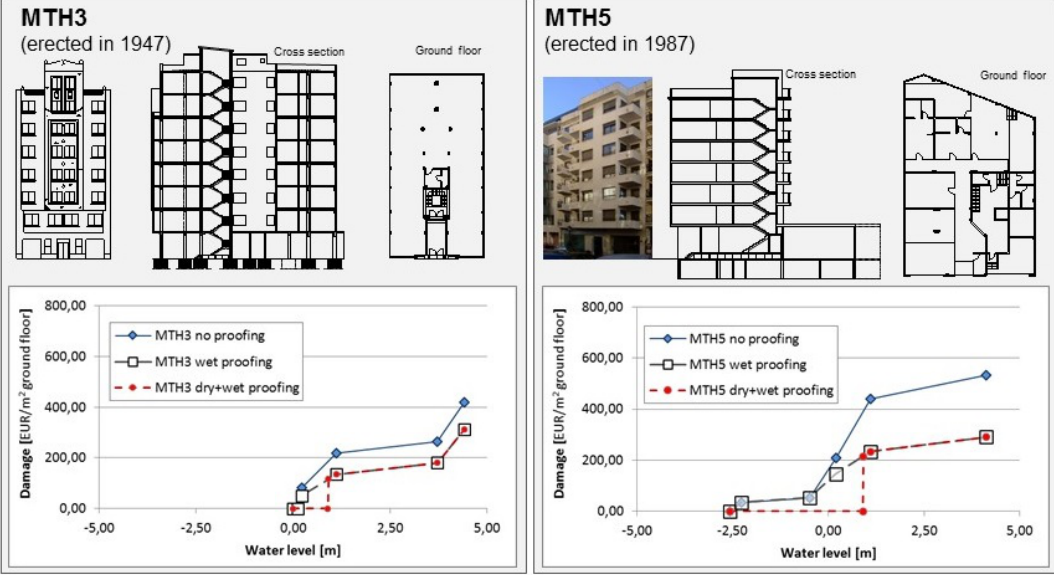
Figure 6. Selected fundamentals and key results of the synthetic vulnerability analysis for two relevant residential building types in the study area Ensanche (source: [43],